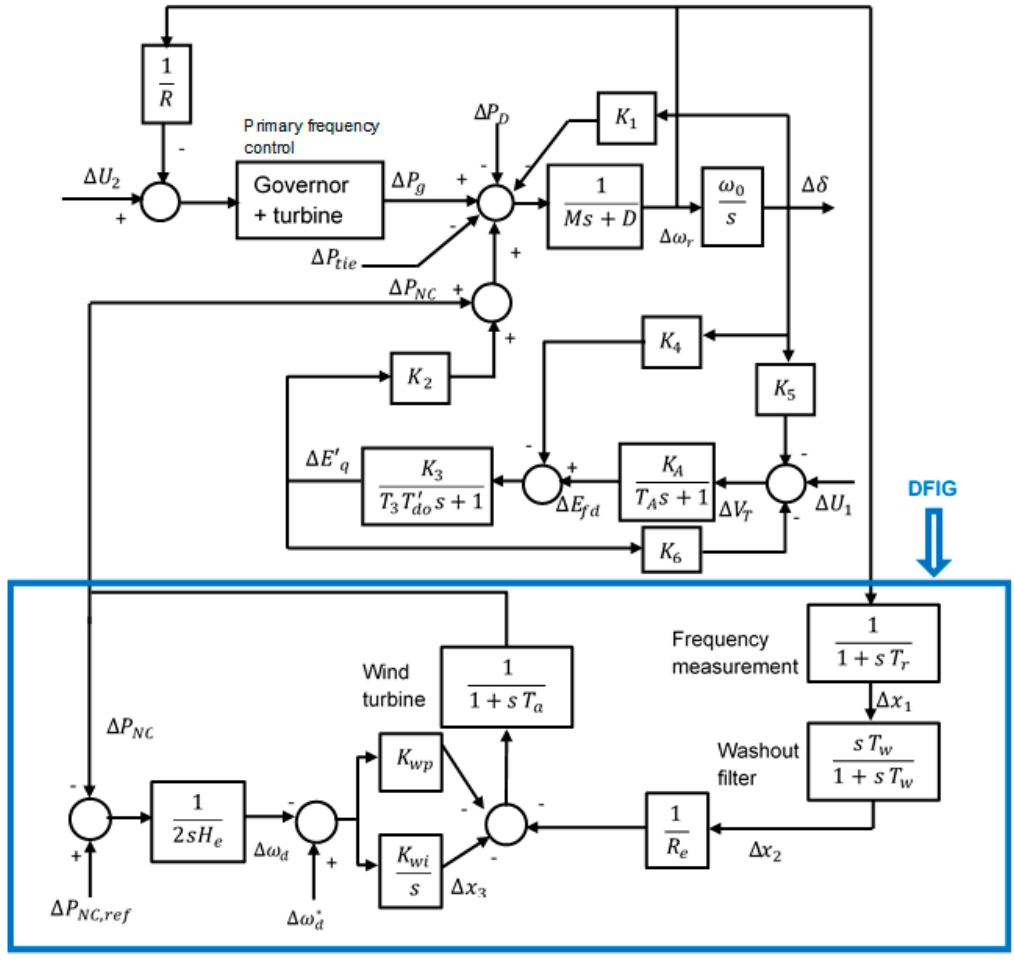
Figure 2. linearized SG and DFIG combined machine model for power sharing Figure 2. Linearized SG and DFIG combined machine model for power